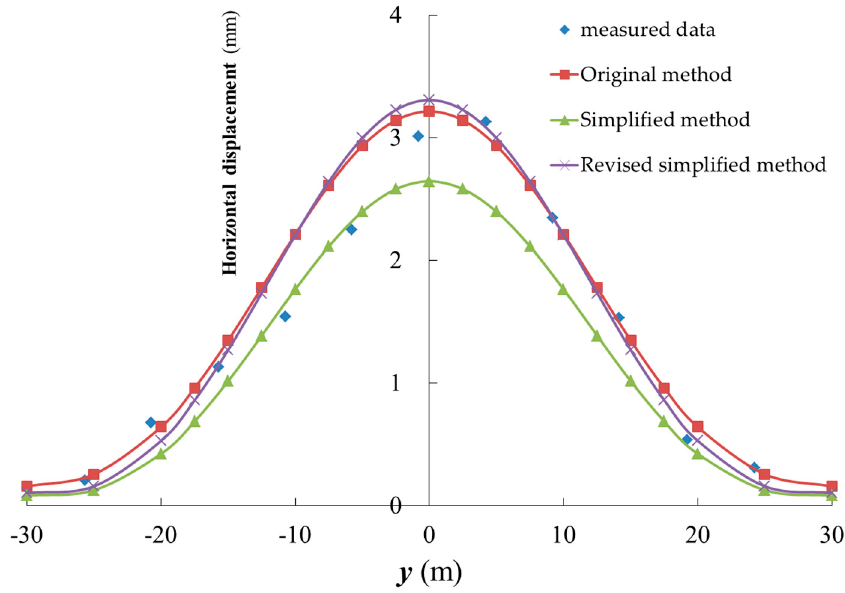
Figure 7. Comparison of the compensated level of horizontal displacement of the tunnel calculated by the original method with that estimated by the simplified method.